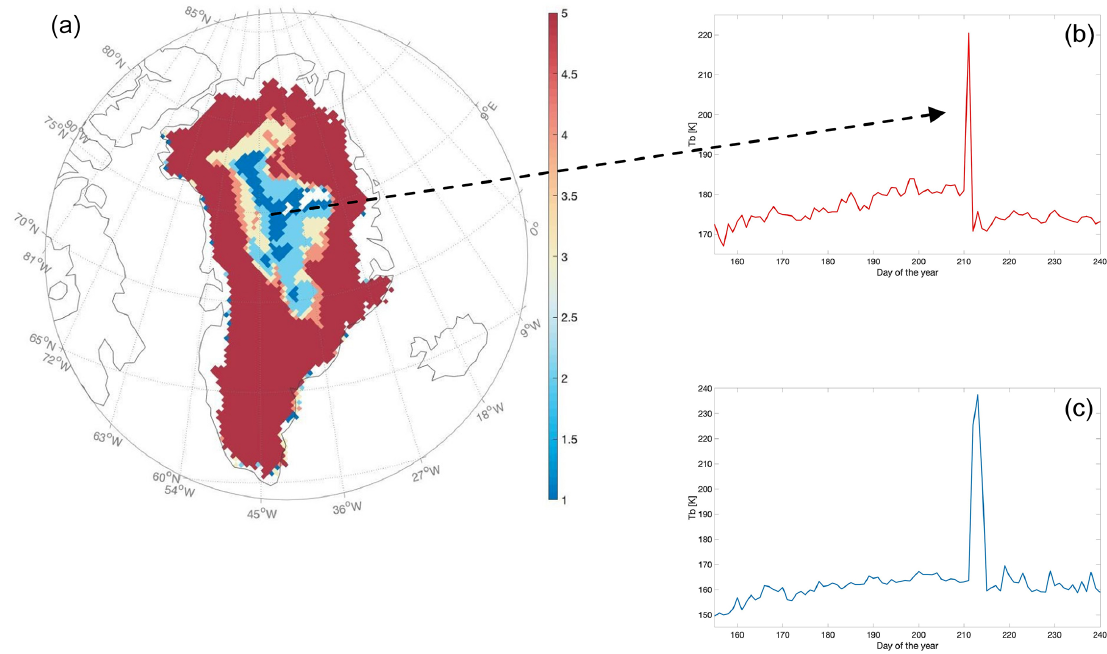
Figure 3. (a) Number of melting days in 2019 obtained from spaceborne passive microwave observations. The data are the same as those in Fig. 1 but the range has been reduced between 1 and 4d to highlight melting occurring in the interior at high elevations. (b, c) Daily time series of spaceborne microwave brightness temperatures for the two selected points indicated by the tail of the